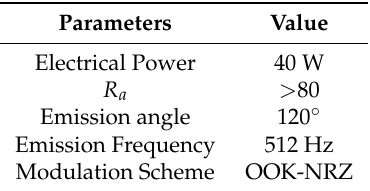
Table 5. Emitter characteristics.